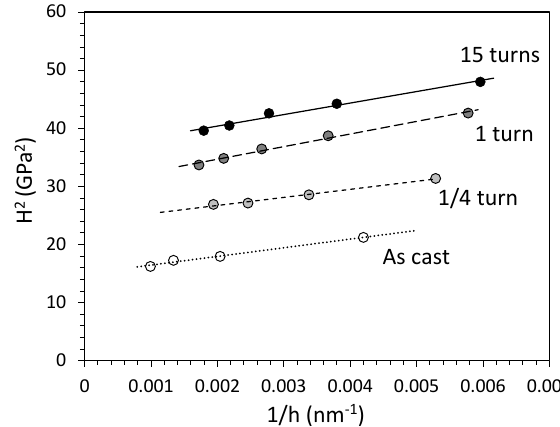
Figure 3. Depth dependence of the hardness plotted for as cast sample and samples HPT strained from 1/4 turn to 15 turns according to Eq. 1.